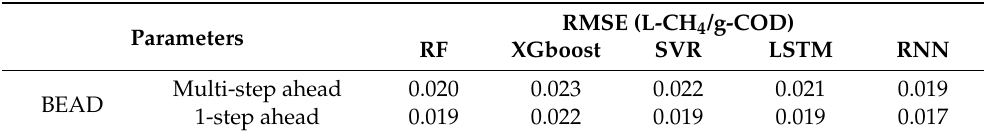
Table 4. RMSE values of BEAD reactor for multi-step ahead and 1-step ahead predictions using various machine learning models with pH as a single input data.